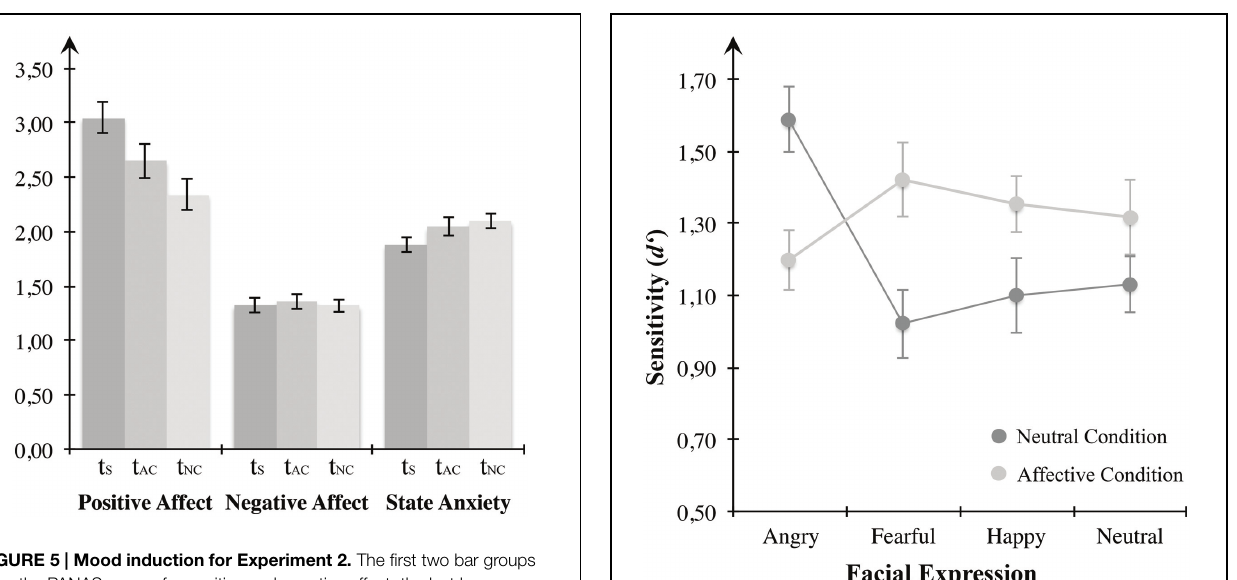
FIGURE 5 | Mood induction for Experiment 2. The first two bar groups form the PANAS scores for positive and negative affect, the last bar group represents the STAI score for state anxiety, t S depicts the first measurement, t AC the measurement after the affective block, and t NC the measurement after the neutral block. Error bars depict ± 1 SEM. and the increase of anxiety between the input measurement and the measurement after the neutral block can be considered a consequence of the challenging face task processing.